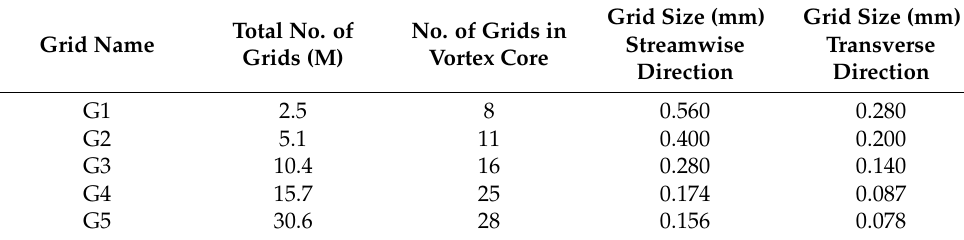
Figure 3. Grid distribution on the foil surface and in transverse and streamwise directions: ( a ) surface distribution and transverse distribution; ( b ) close-up view of vortex core region; ( c ) streamwise distribution. Table 1. Computational grid resolutions.